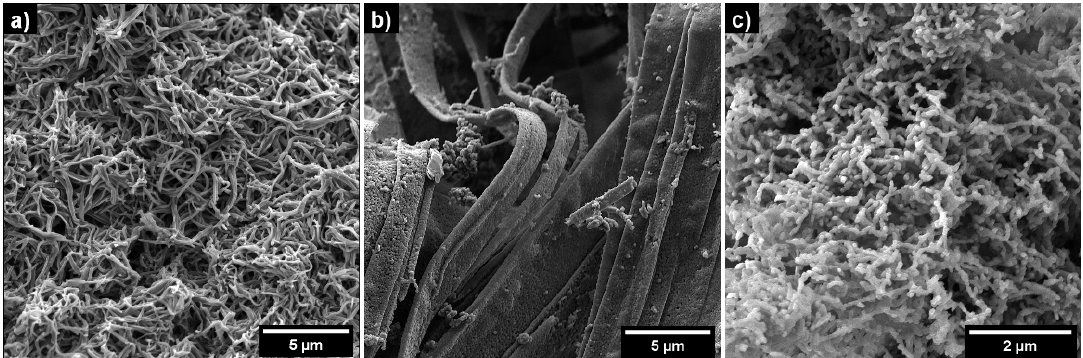
Figure 1. The morphology of prepared polypyrrole (PPy) powders: ( a ) Methyl Orange (PPy-MO) nanotubes, ( b ) Methylene Blue (PPy-MB) nanobelts, ( c ) Eriochrome Black T (PPy-EB) nanofibers.